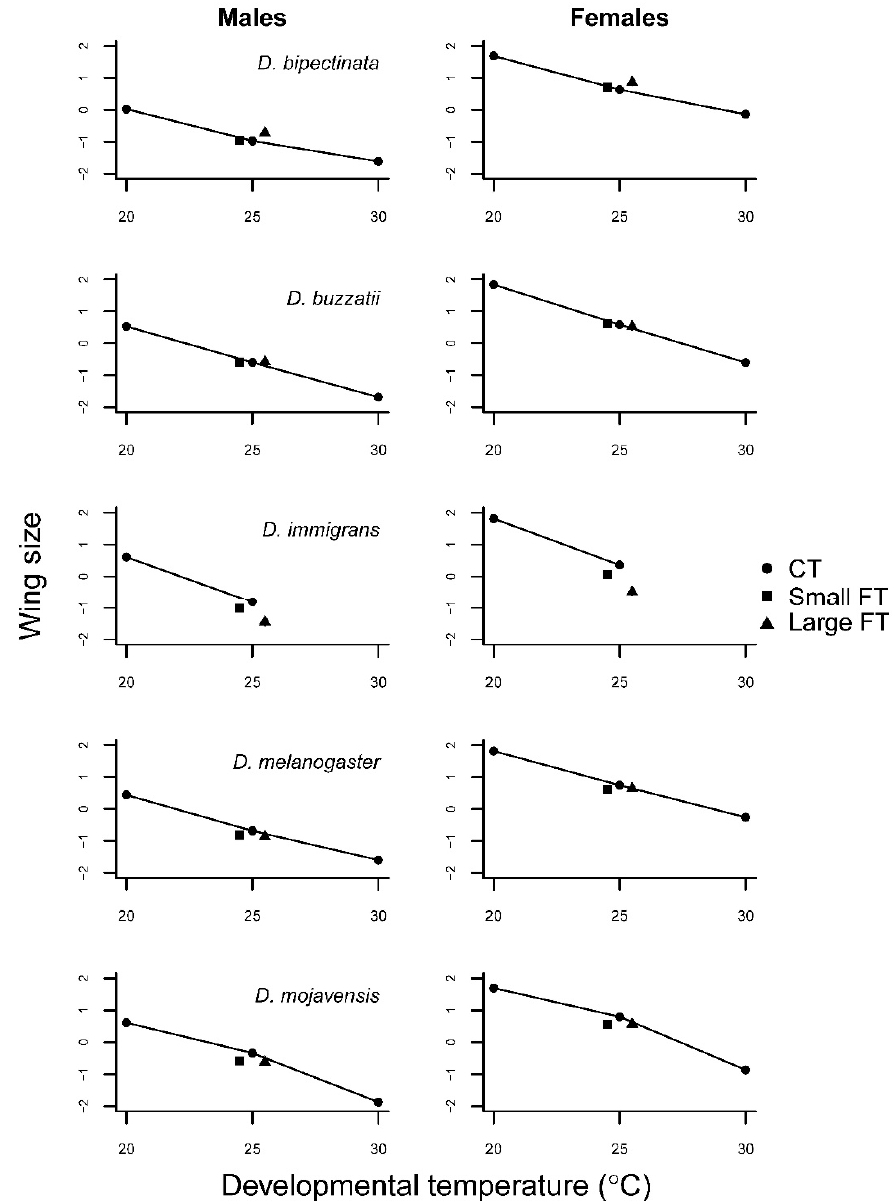
Figure 3. Mean wing size as a function of developmental temperature regimes in five Drosophila species with 95% confidence intervals. The error bars are not visible because they are hidden behind symbols.